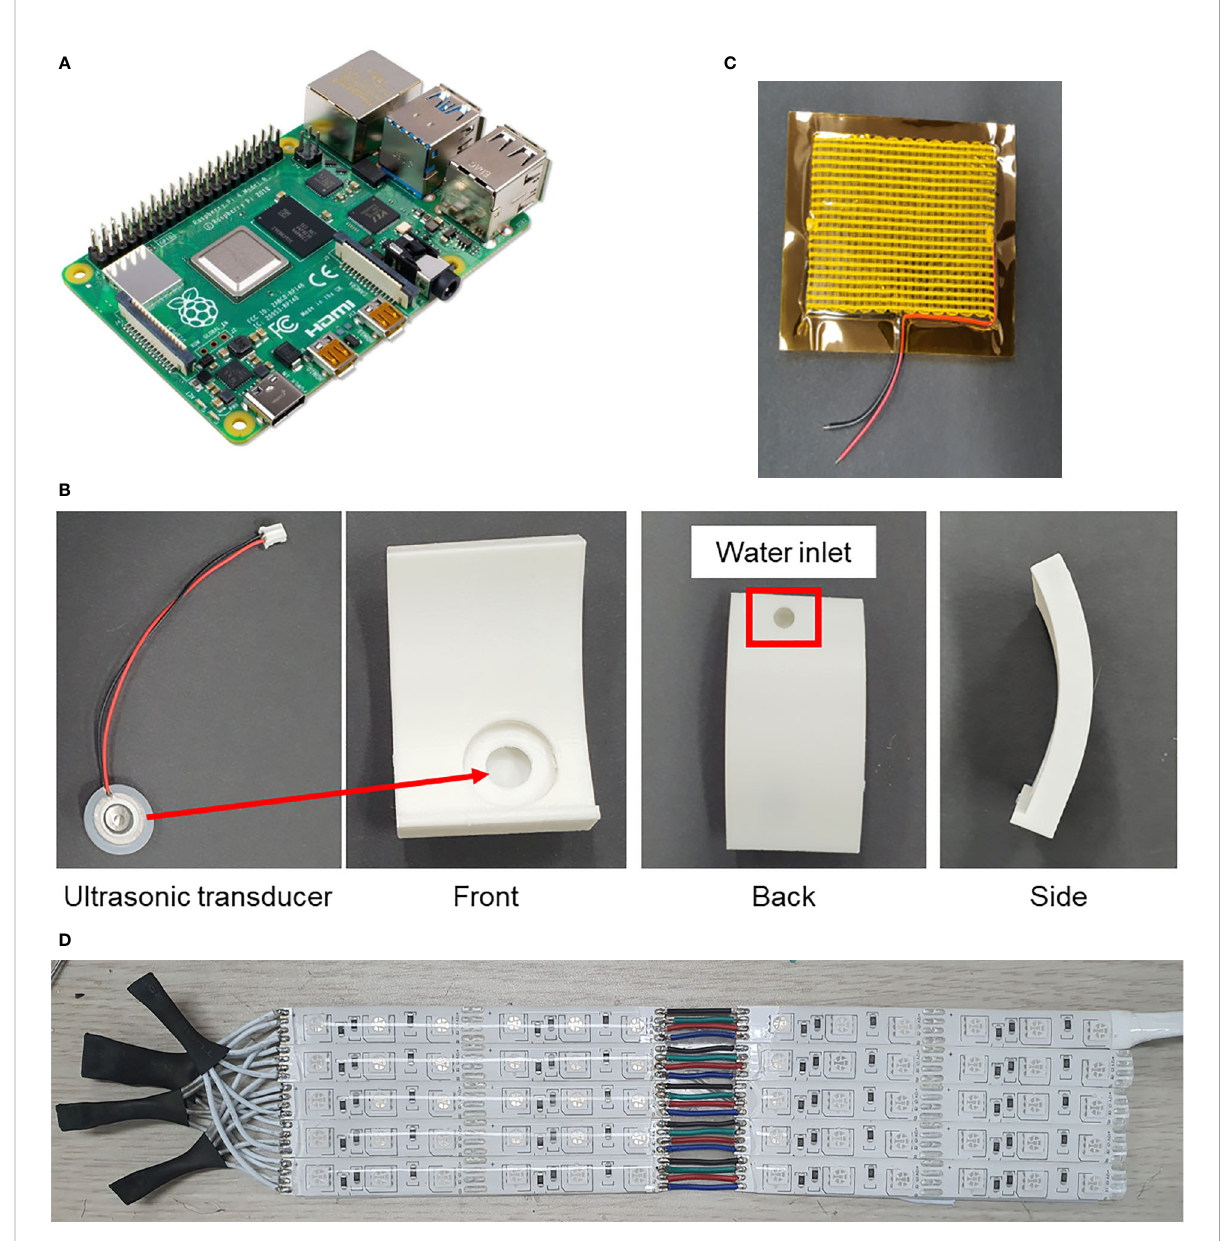
FIGURE 2 Main elements of the cultivator. (A) Raspberry Pi 4, (B) water tank and ultrasonic humidi fi er, (C) heating wire pad, and (D) tailored RGB